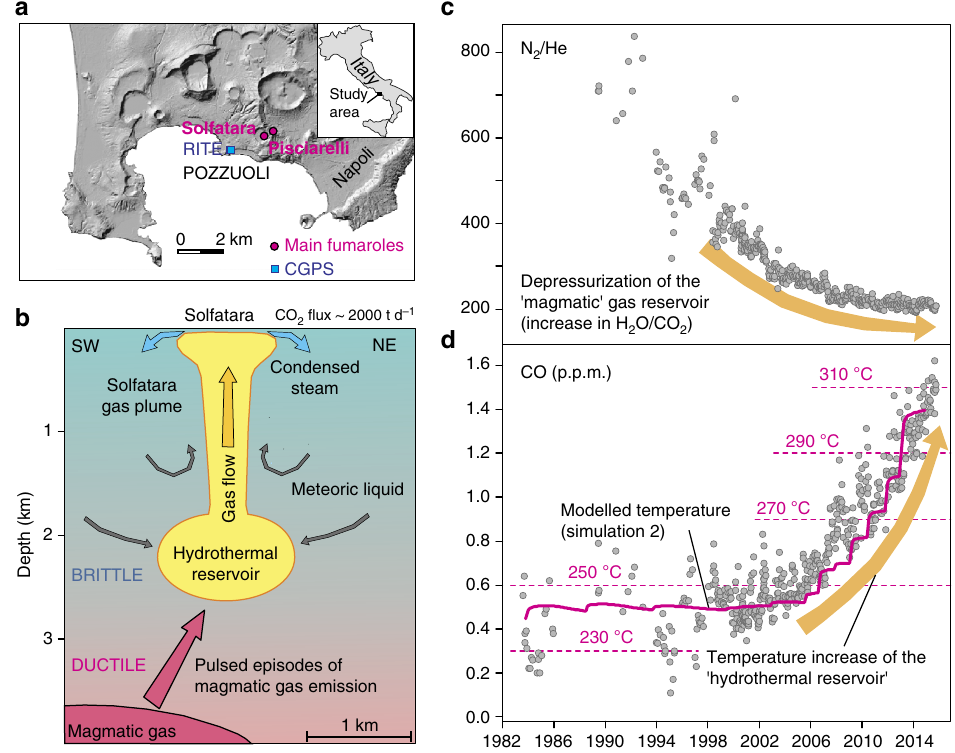
Figure 3 | The hydrothermal system of CFc and its signals. ( a ) Locations of CFc and the main hydrothermal sites: Solfatara and Pisciarelli. ( b ) Conceptual model of the hydrothermal system feeding the two manifestations: a 4-km-deep zone of magmatic gas accumulation that supplies fluids to a shallower part where they vaporize liquid of meteoric origin to form a 2-km-deep vertical plume of gas 14 . Previous geochemical investigations based on the stable isotopes of water revealed the presence of typical magmatic waters in the Solfatara fumarole vents 50 . ( c ) Temporal evolution of the N 2 /He ratio at the Solfatara fumaroles. ( d ) Time series of the CO content in the Solfatara fumaroles. The increasing trend indicates heating of the system, and matches the TOUGH2 (ref. 26) model-derived temperatures (magenta line) exceptionally